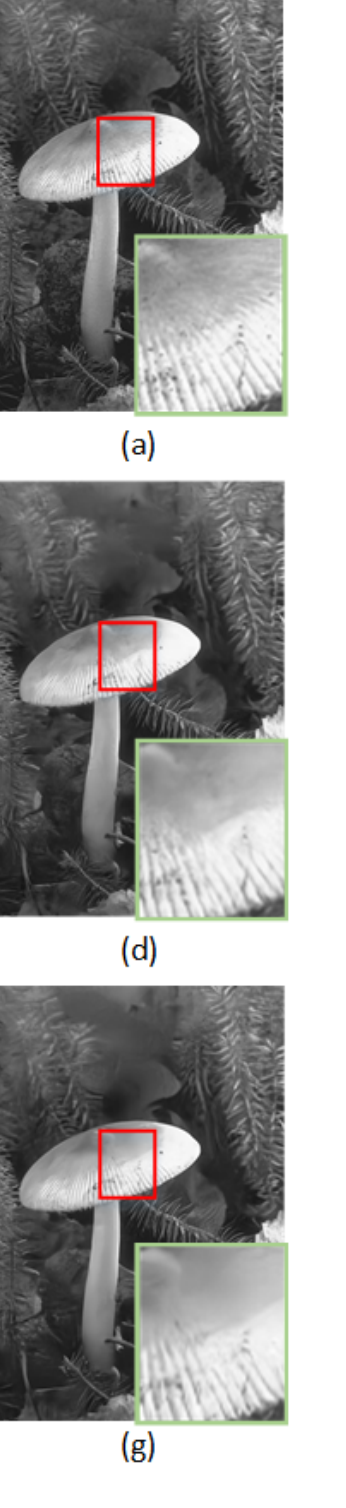
Figure 6. Denoising results of different methods on one image from BSD68 with noise level σ =